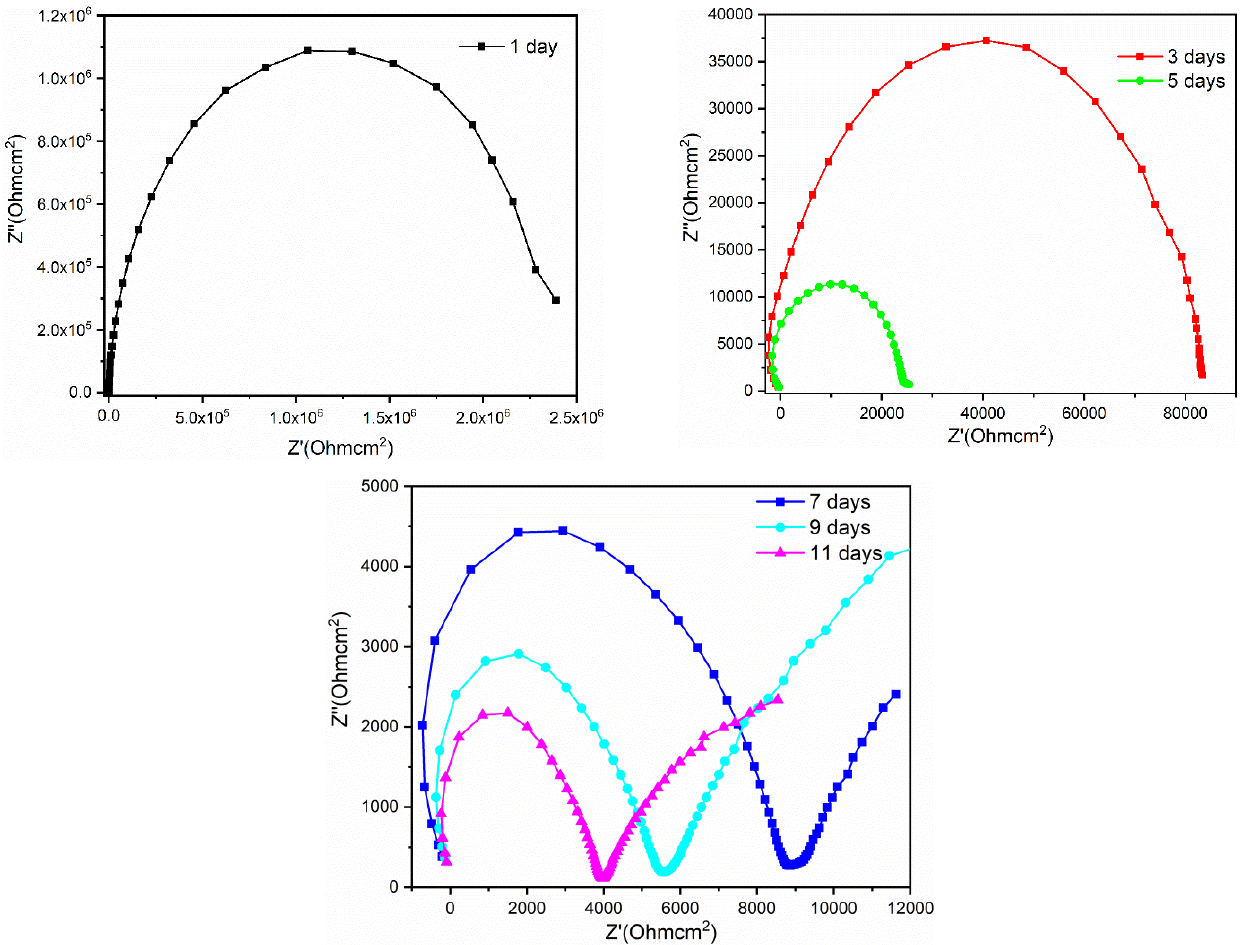
Table 2. EIS parameters of CPEEUA/FS-40 nanocomposite.